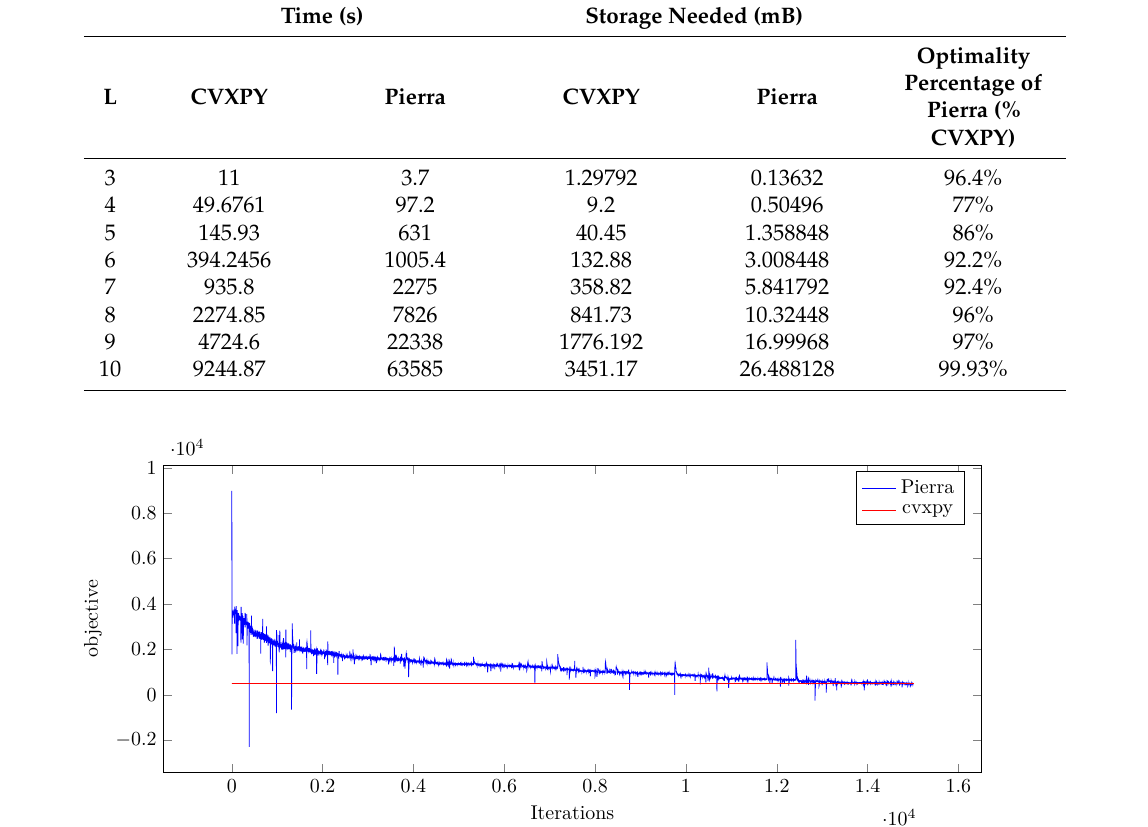
Figure 1. Evolution of the objective function along 15,000 iterations in Pierra’s algorithm compared to CVXPY’s solution for L =